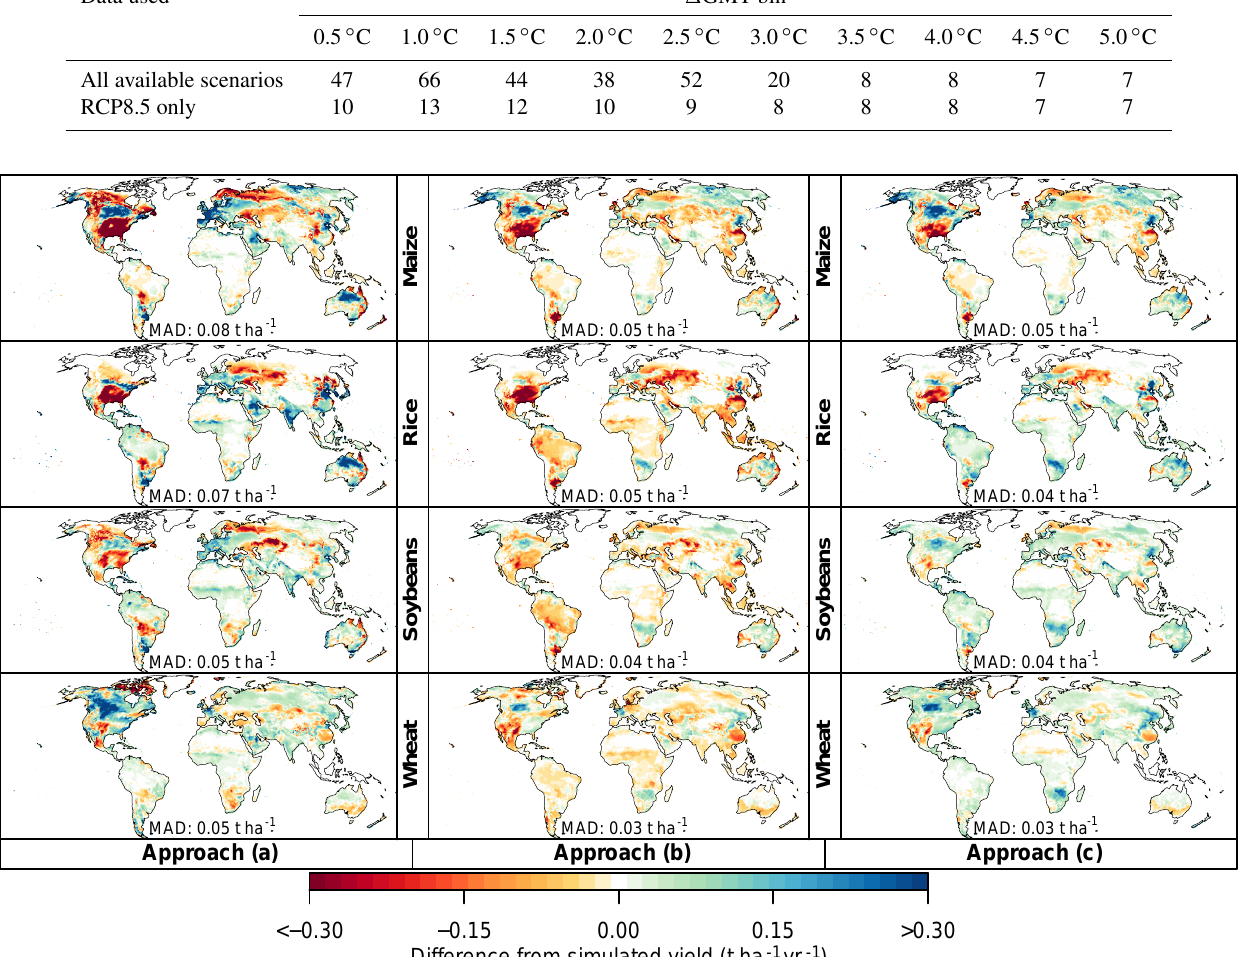
Table 2. Number of years of yield data available in each (cid:49) GMT bin for HadGEM2-ES. Only RCP8.5 reaches warming levels above 3 ◦ C. Data used